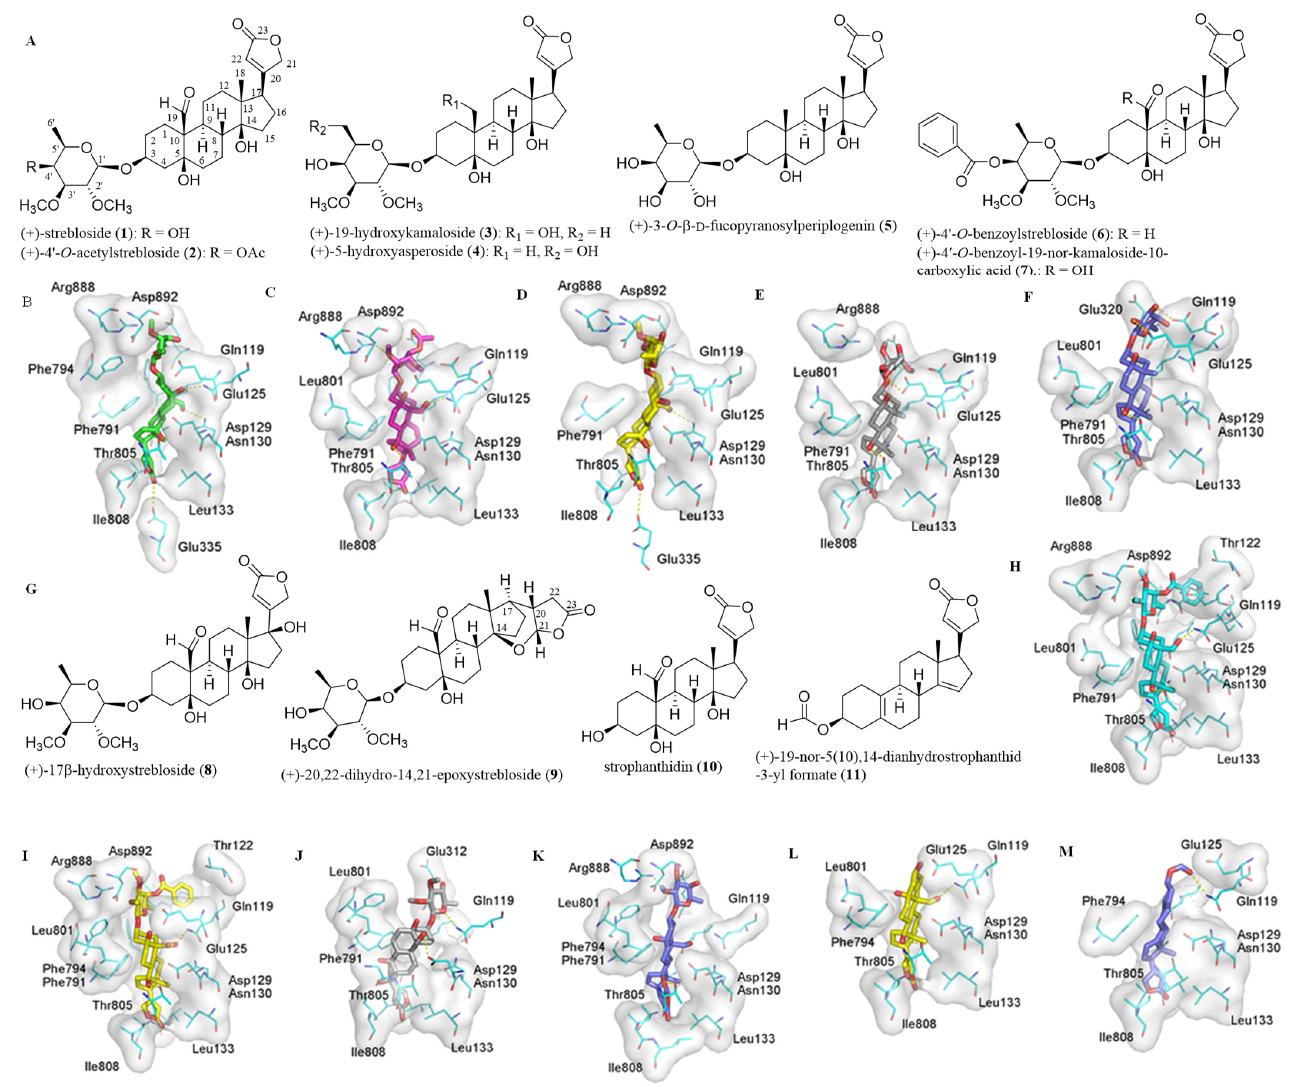
Figure 1. Structures of (+)-strebloside ( 1 ), (+)-4'- O -acetylstrebloside ( 2 ), (+)-19-hydroxykamaloside ( 3 ), (+)-5-hydroxyasperoside ( 4 ), (+)-3- O - β - D -fucopyranosylperiplogenin ( 5 ), (+)-4'- O -benzoylstrebloside ( 6 ), and (+)-4 ′ - O -benzoyl-19-nor-kamaloside-10-carboxylic acid ( 7 ) ( A ) and (+)-17 β -hydroxystrebloside ( 8 ), (+)-20,22-dihydro-14,21-epoxystrebloside ( 9 ), strophanthidin ( 10 ), and (+)-19-nor-5(10),14-dianhydrostrophanthidin-3-yl formate ( 11 ) ( G ) and docking profiles for 1 (green, B ), 2 (pink, C ), 3 (yellow, D ), 4 (gray, E ), 5 (blue, F ), 6 (cyan, H ), 7 (yellow, I ), 8 (gray, J ), 9 (blue, K ), 10 (yellow, L ), and 11 (blue, M ) and NKA. The modeled structure of human NKA (hNKA) was used as the receptor, and the conformations of 1 – 11 generated by LigPrep were used in molecular docking against the receptor by AutoDock Vina [14]. Table 1. Docking scores from the binding to NKA and cytotoxicity of strebloside ( 1 ) and its derivatives ( 2 – 11 ). a. Compound 3 contains a hydroxymethyl rather than a formyl group at the C-10 po- sition, and the hydrogen bond formed between the C-19 hydroxy group and the Asn130 Compd. residue of NKA could be weaker than that formed between the C-10 formyl group of 1 and this same residue. This weaker interaction leads to a slight rotation of the steroid core of 3 to break the hydrogen bond formed between the C-5 hydroxy group and the Gln119 side chain of NKA observed in 1 (Figure 1). However, the binding poses of 1 , 3 , and ouabain are closely similar (Figure 1), and thus the binding affinity and cytotoxicity of 3 do